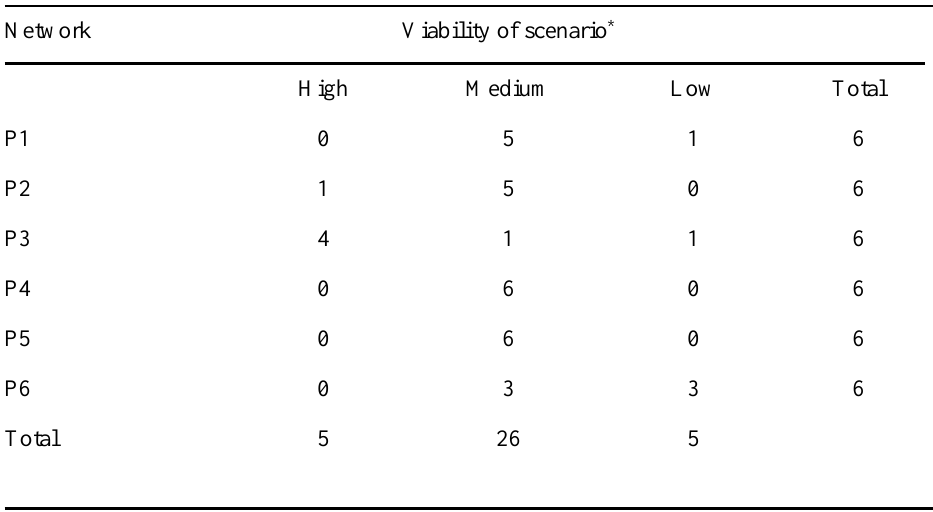
Table 5. Number of scenarios under different levels of viability based on six types of